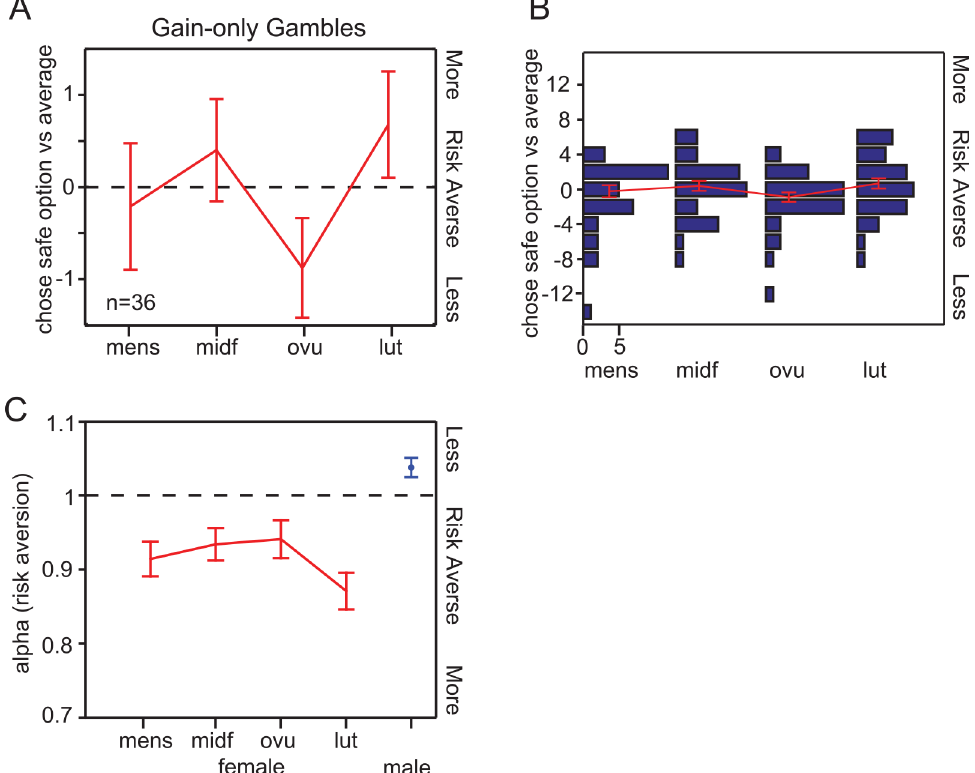
Fig 4. Results for gain-only trials in gambling experiment. (A) Effect of menstrual phase on the number of times subject chose the safe/certain option over the risky option in gain-only trials. ( B) Histogram of the number of times the safe option was chosen by each individual subject, computed as the difference between the number of safe choices in each cycle phase and the average number of safe choices across cycle phases. Fig 4A is superimposed on the histogram for comparison. ( C) Effect of menstrual phase on risk aversion. Parameter fits are estimated simultaneously for all phases with controlling for session order effects (see S1 File for details on the fitting procedure). Parameter estimates for an age-matched male population are also plotted on this for comparison. Subjects were more risk averse during the luteal phase than during ovulation (p = 0.048) or the mid-follicular phase (p = 0.056).